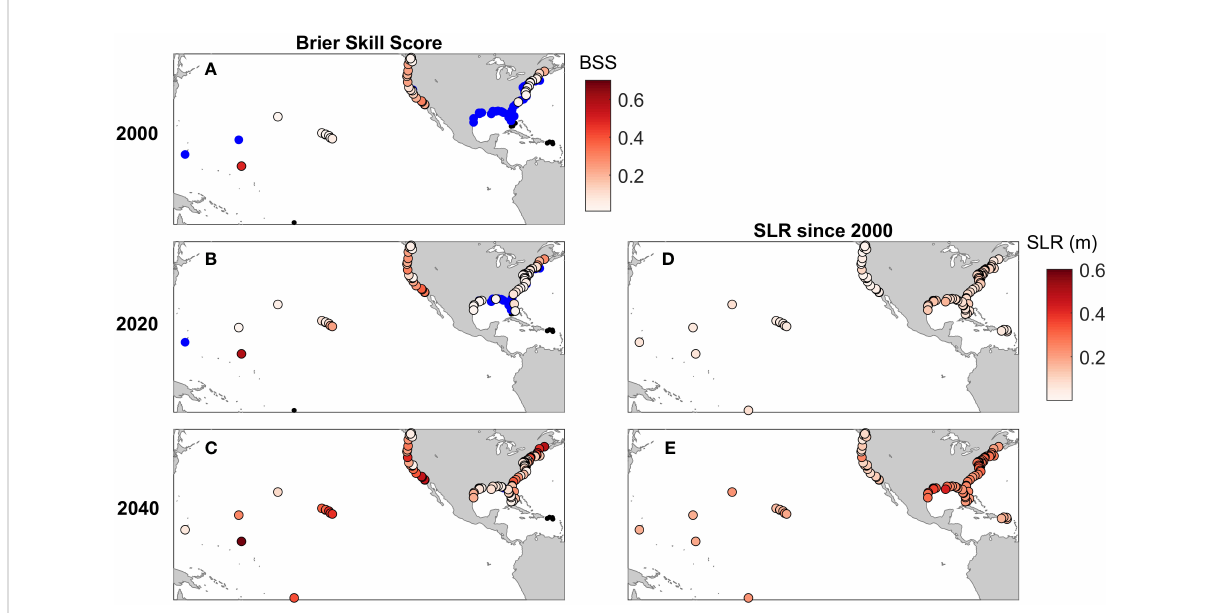
FIGURE 9 Brier Skill Scores for HTF predictions made assuming mean sea level (MSL) is equivalent to the detrended mean at about 2000 (A) and 2020 (B) and for the intermediate SLR projection for 2040 (C) . Blue dots indicate insigni fi cant skill (BSS< BSS Conf.), while small black dots (e.g. Caribbean and Florida Keys) indicate less than 10 HTF days occurred over the MSL adjusted 19-year period. The estimated SLR since 2000 is shown for 2020 (D) and the intermediate SLR projection for 2040 is shown (E) .